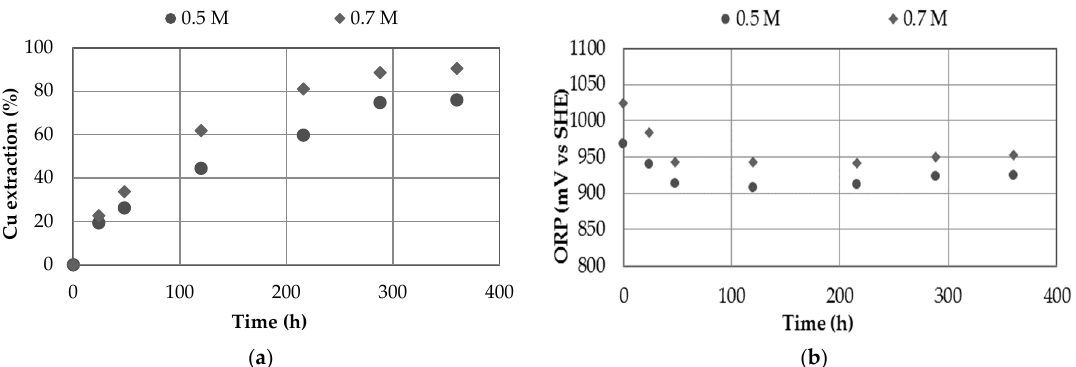
Figure 4. ( a ) Copper extraction (%) vs. time (h) at di ff erent equivalent sodium nitrate and sulfuric acid concentration: [NaNO 3 ] = [H 2 SO 4 ] = 0.5 and 0.7 M. ( b ) Redox potential (mV) vs. time (h) at di ff erent sulfuric acid concentration: 0.5 and 0.7 M. Experimental conditions: seawater as dissolvent, 45 ◦ C and sample A.